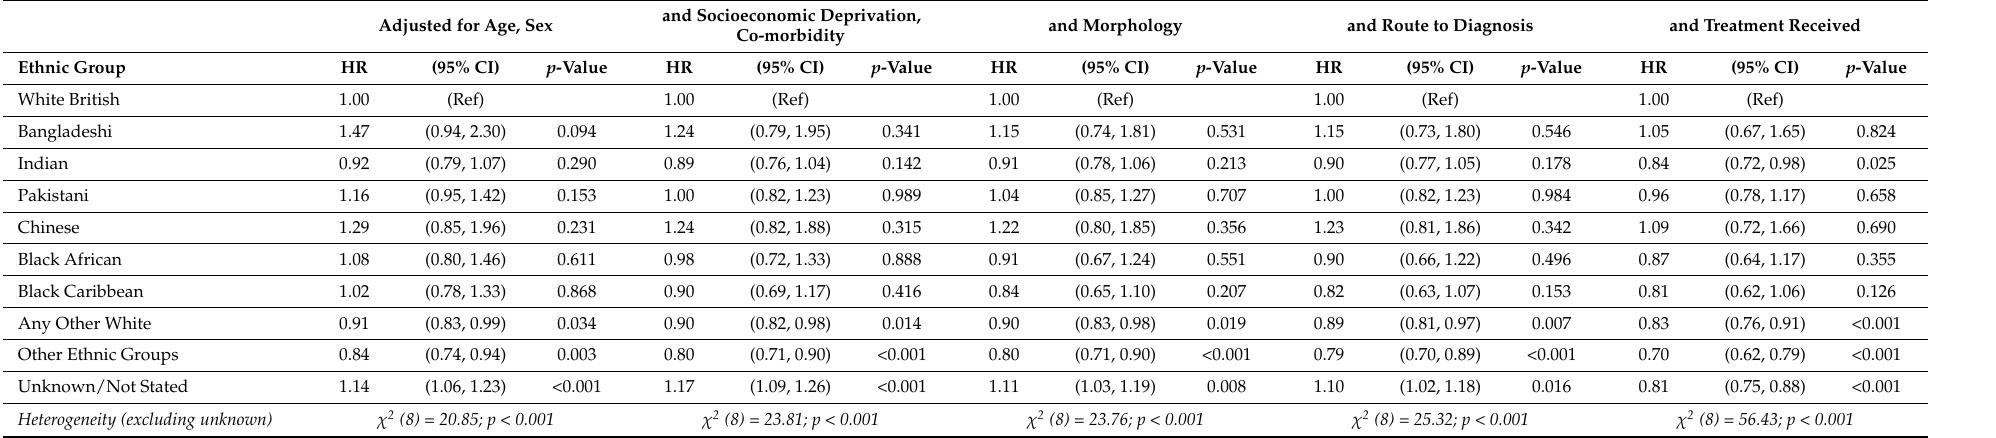
Table 3. Survival analysis of different ethnic groups of patients diagnosed with malignant primary brain tumour in England, 2012–2017. Adjusted for Age, Sex and Socioeconomic Deprivation, Co-morbidity and Morphology and Route to